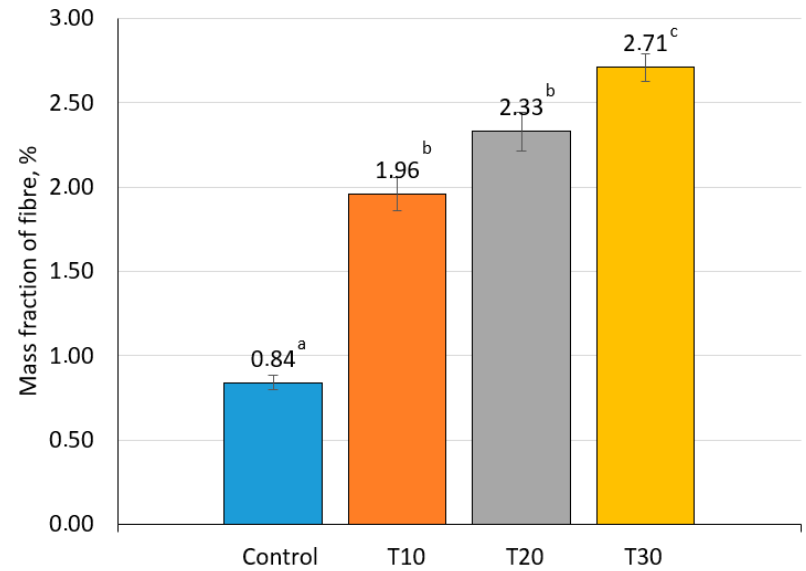
Figure 2. Fiber content in canned goat meat samples (the values for bars sharing different letters (a–c) are significantly different ( p < 0.05)).